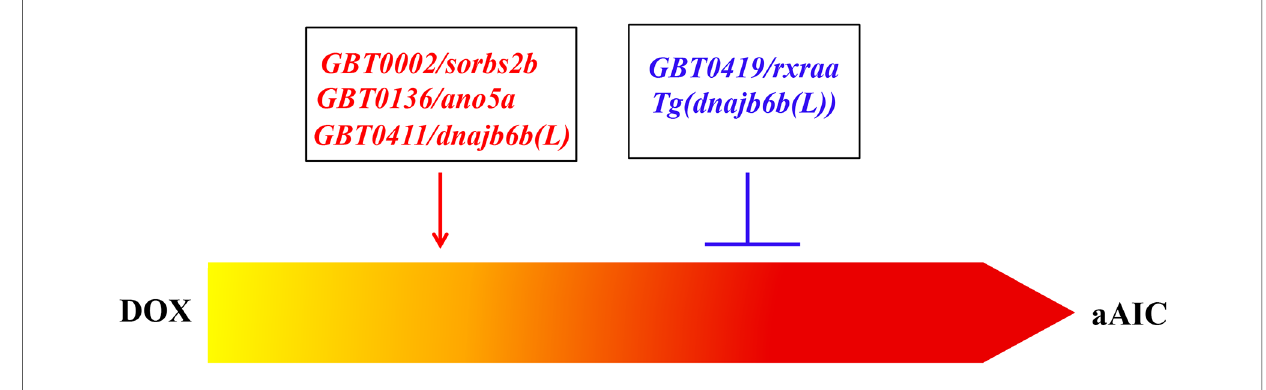
FIGURE 1 Both deleterious modi fi ers and salutary modi fi ers of AIC can be identi fi ed by using a forward mutagenesis screening approach. While GBT0002/sorbs2b, GBT0136/ano5a, and GBT0411/dnajb6b( L ) were identi fi ed as deleterious modi fi ers, GBT0419/rxraa was identi fi ed as a salutary modi fi er. Mechanistic studies of GBT0411/dnajb6b( L ) identi fi ed Tg(dnajb6b( L )) that exerts salutary modifying effects on AIC